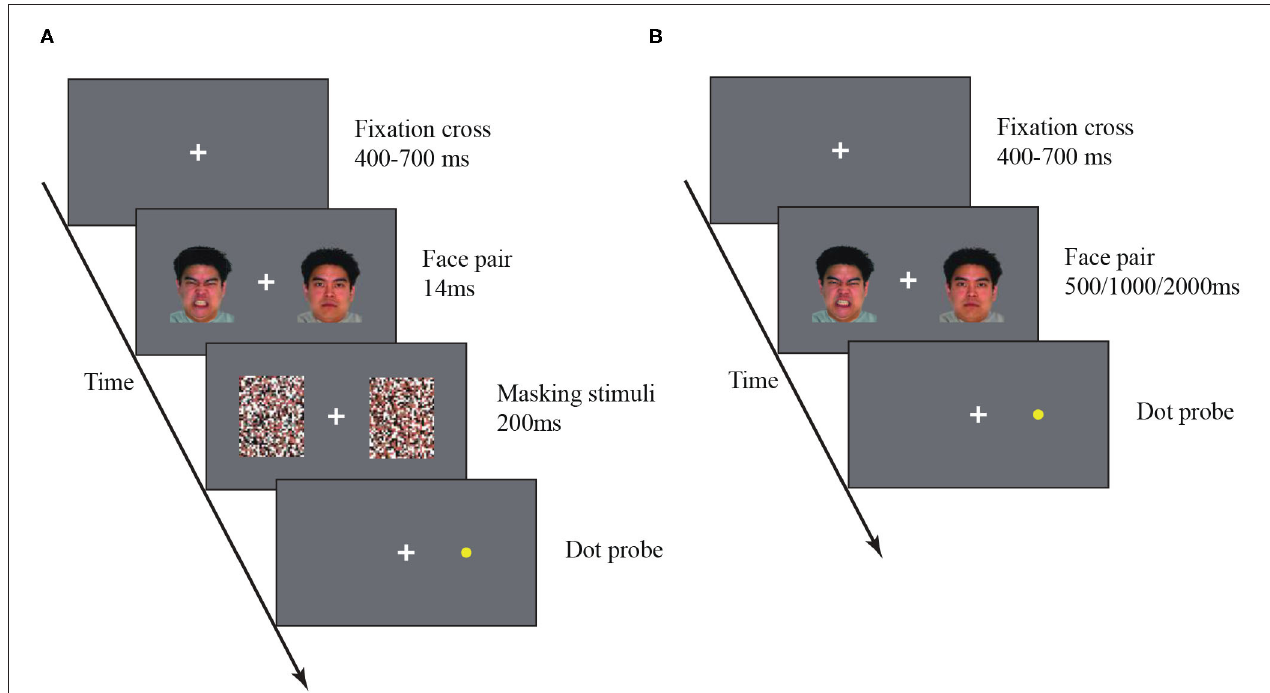
FIGURE 1 | Flow diagram of the subliminal (A) and supraliminal (B) dot-probe